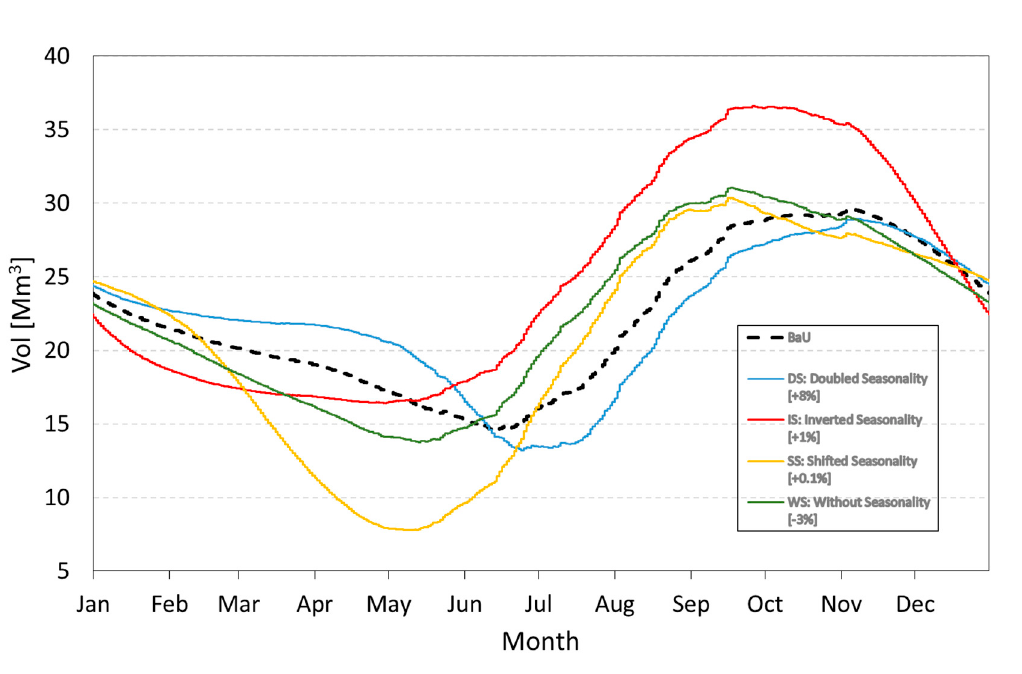
Figure 8. Evolution of the reservoir’s volumes at 2030 for all price scenarios with a 95% confidence interval. Bracket values show the variations of income compared to business as usual (BaU).